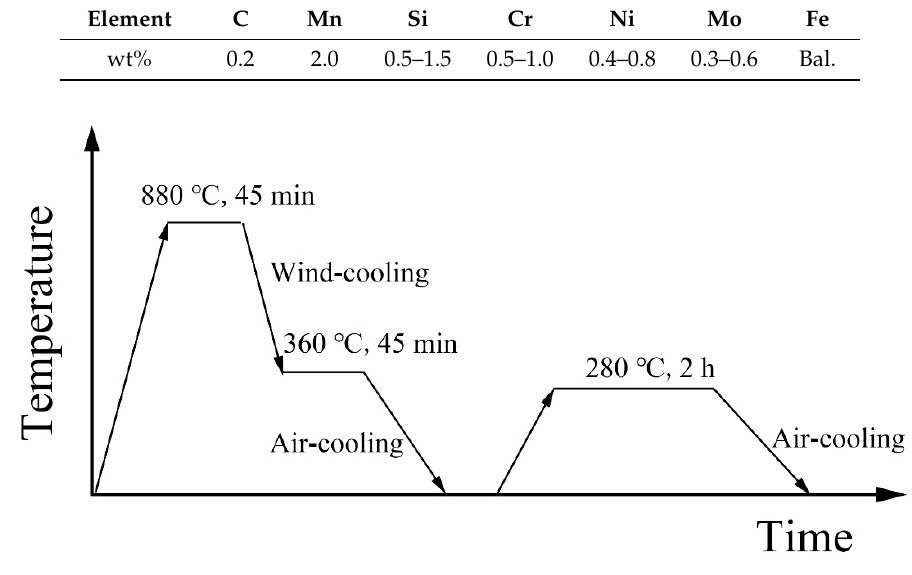
Figure 1. Heat treatment process.